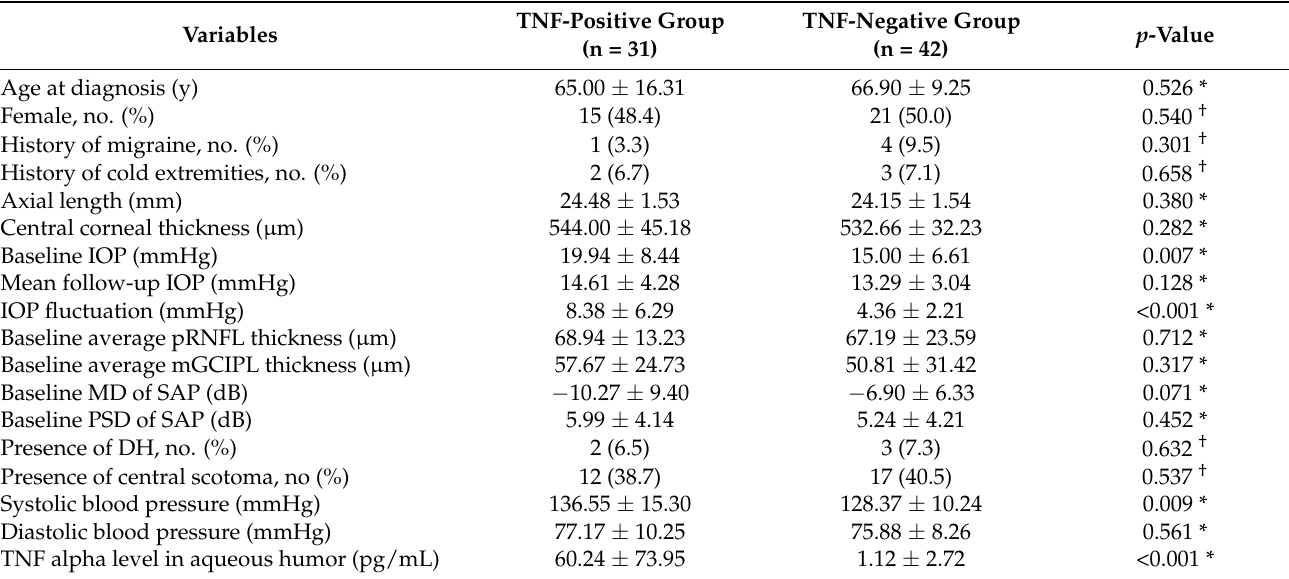
Table 1. Comparison of baseline clinical characteristics between TNF- α -positive and TNF- α -negative open-angle glaucoma